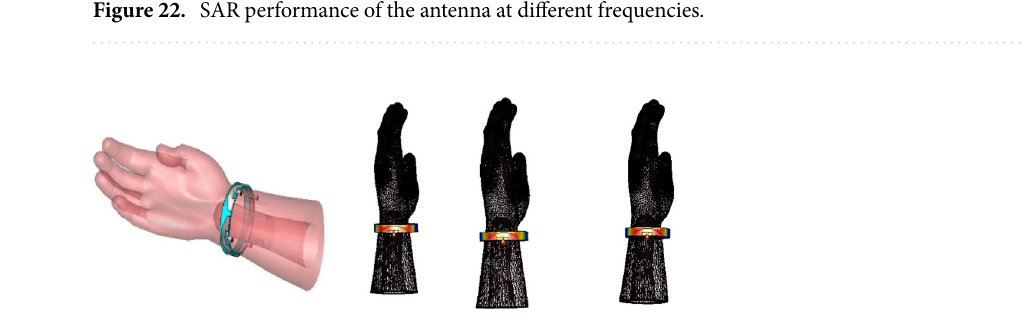
Figure 22. SAR performance of the antenna at different frequencies.